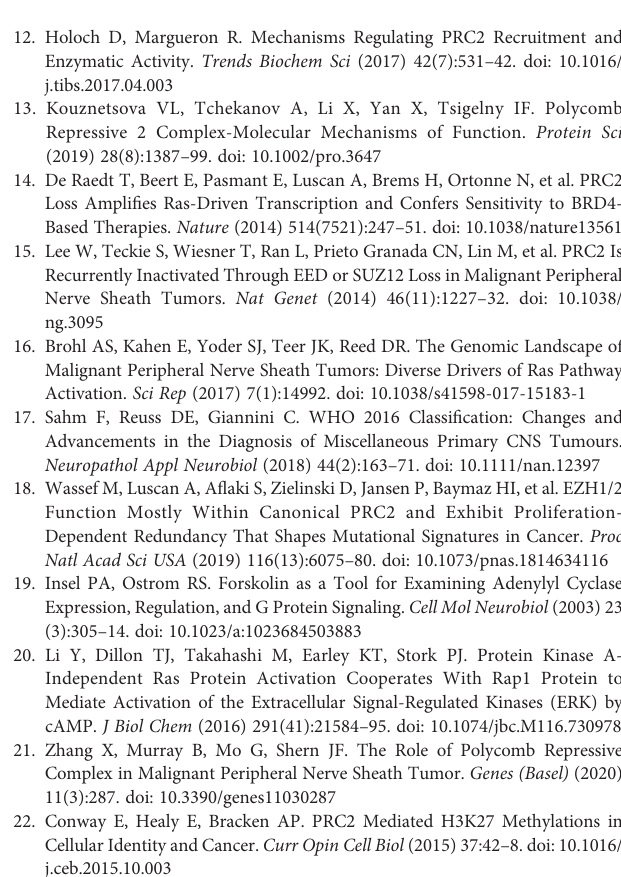
Supplementary Figure S1 | Overall survivals of 4 hub gene were performed using COX survival analysis. High expression of ADCY1 showed worse survival (A) , while the other three genes including ADRA2C, BDKRB1 and BDKRB2 had no signi fi cant difference in the survival rate in MPNST (B – D) . Supplementary Figure S2 | Effects of overexpression of SUZ12 on proliferation of sNF96.2 and ipNF05.5 cell lines. sNF96.2 and ipNF05.5 cell lines were transfected with SUZ12 lentivirus, and proliferation ability was tested by CCK-8 kit. The results showed that the proliferation of sNF96.2 cells was signi fi cantly reduced (A) , but ipNF05.5 was not (B) . (Two-way ANOVA, *P <